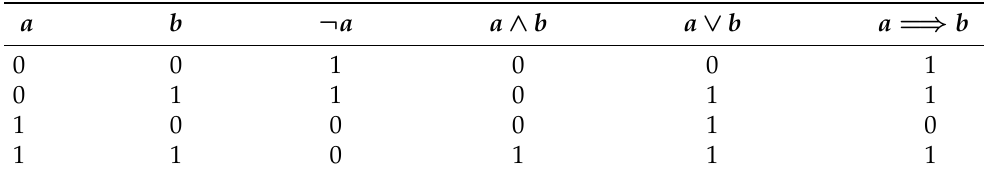
Table 1. Truth table of classical